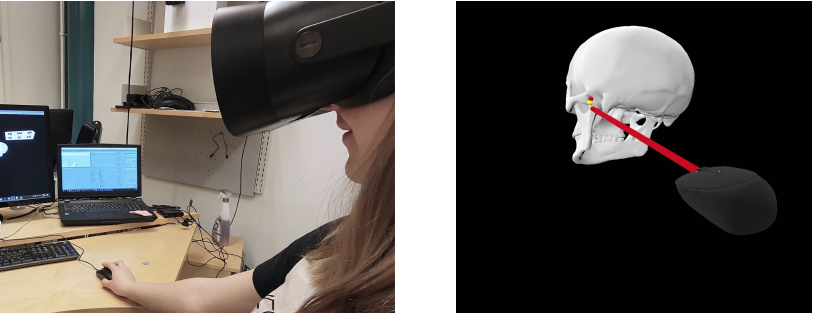
Figure 1. Mouse interaction method outside VR ( left ). Mouse marking method inside VR and the study task ( right